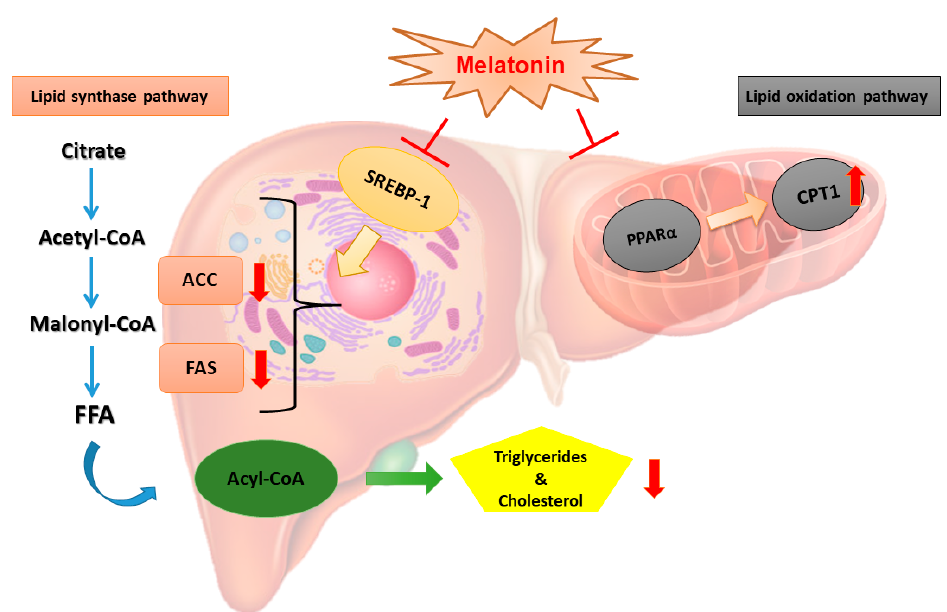
Figure 6. Proposed mechanism of melatonin-mediated modulation of the lipid metabolism pathway in hamsters fed an HFD. The effects of melatonin on the fatty liver of hamsters fed an HFD may occur through inhibition of metabolic enzymes of the lipogenic pathway and lipid oxidative pathway. The diagram demonstrates that melatonin might inhibit the lipogenic enzymes ACC and FAS during cholesterol synthesis.